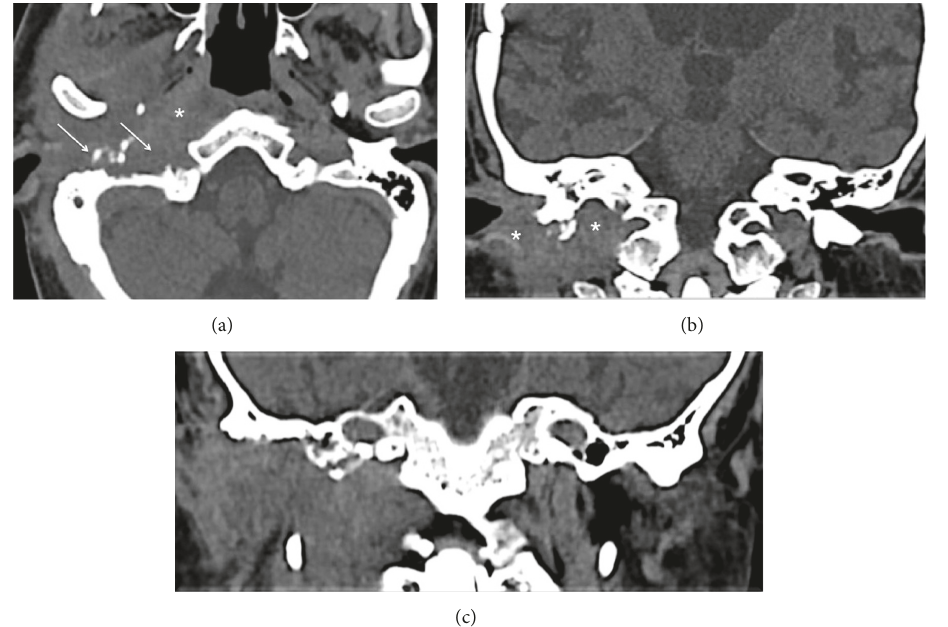
Figure5:(a)Inflammatoryinfiltrationattheleveloftheprevertebralandsuperiorpharyngealconstrictormuscles(asterisk).Arrowsshowthe massiveerosionofthetympanicpartofthetemporalbone.(b)Inflammatorychangesatthelevelofthejugularfossaandparotidcompartment (asterisks). (c) A soft tissue lesion in the parapharyngeal and parotid